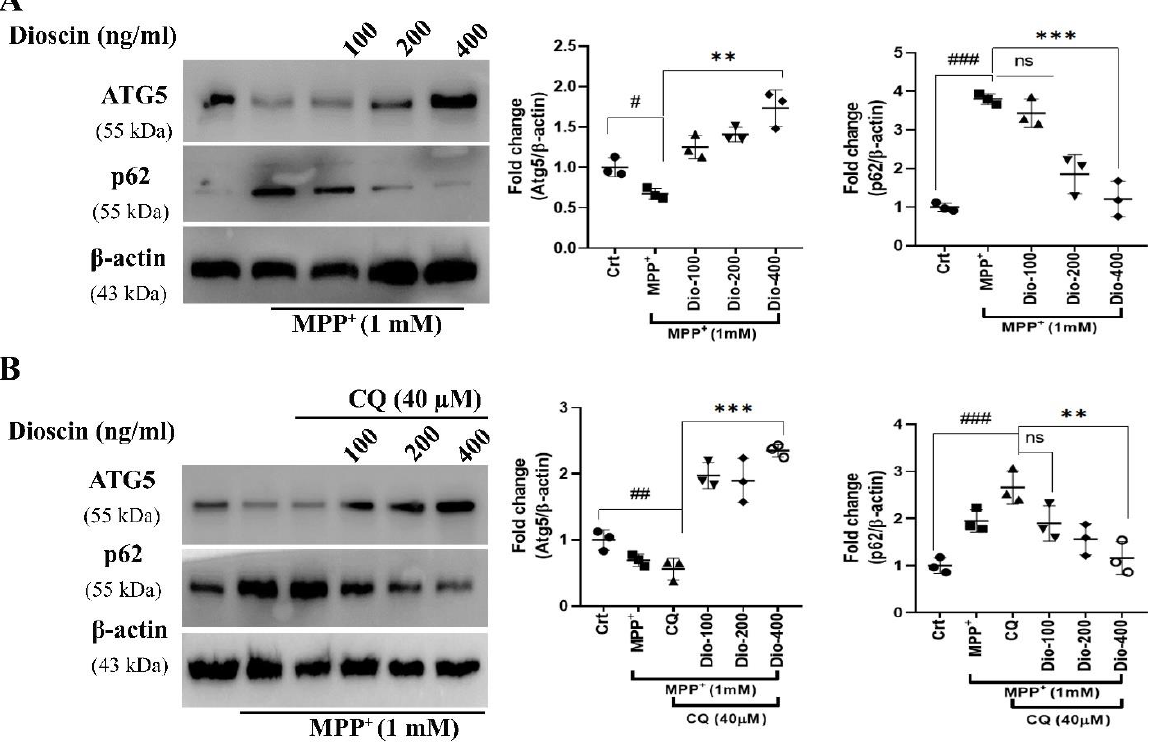
Figure 5. Dioscin dose-dependently activates autophagy. Representative data of ATG5 and p62 im- munoblots of whole-cell (SH-SY5Y) lysates. ATG5 and p62 were used as an indicator of sequestosome formation. Cells were pre-treated with different doses of dioscin ( A ) and autophagy inhibitor CQ (40 μM) ( B ), followed by induction of MPP + (1mM) for 24 h. The optical density was measured using Image J software and presented as fold changes. Each WB is representative of 3 independent experiments. The bar graphs represent the ratio of respective protein/β-actin normalised against control (non-treated) samples or MPP + or MPP + +CQ-treated cells and are means ± SEM of 3 independent experiments (n = 3). ns = not significant; # p < 0.05, ## p < 0.01 and ### p < 0.001, in comparison to non-treated group; * p < 0.05, ** p < 0.01 and *** p < 0.001, compared to toxin and treatment group.